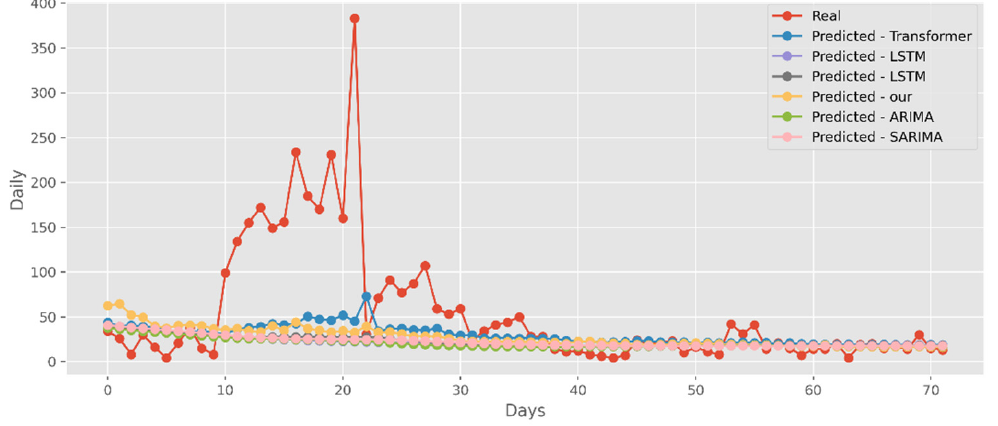
Figure 17. Comparison of COVID ‐ 19 prediction models of deaths in VA.